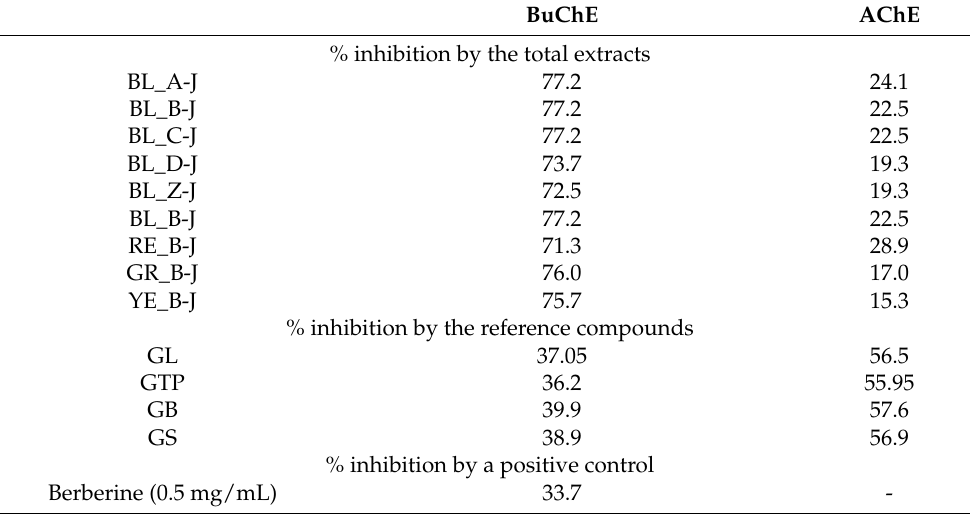
Table 3. The average results of anti-enzymatic assays for the total extracts and the reference com- pounds, measured spectrophotometrically in the modified Ellman’s